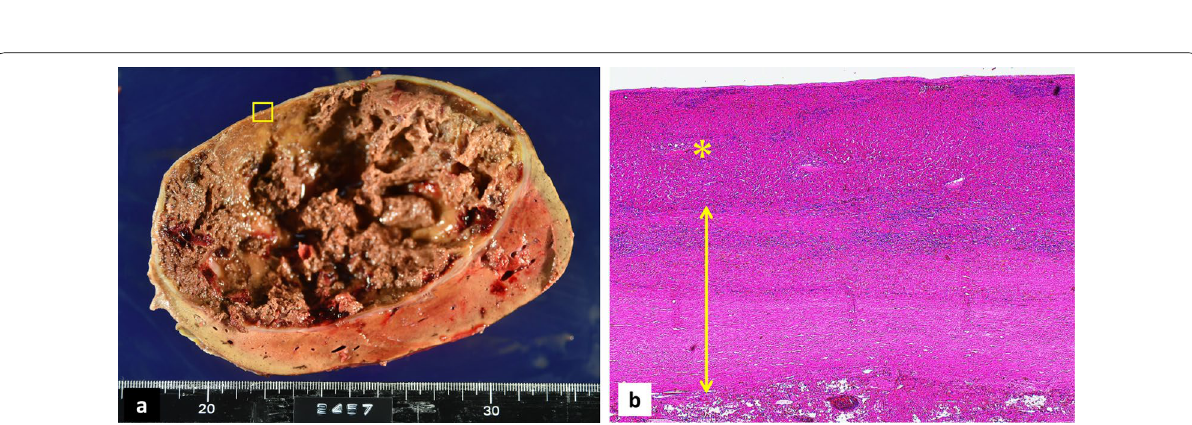
Fig. 4 Pathological findings. a Tumor was covered with a fibrous cap, and a clot was found inside. b Tumor edge ( □ ) in a is enlarged, the cyst wall consisted of vitrified connective tissue, and no covering epithelium was confirmed (double arrow). It is covered with thinly stretched liver parenchyma